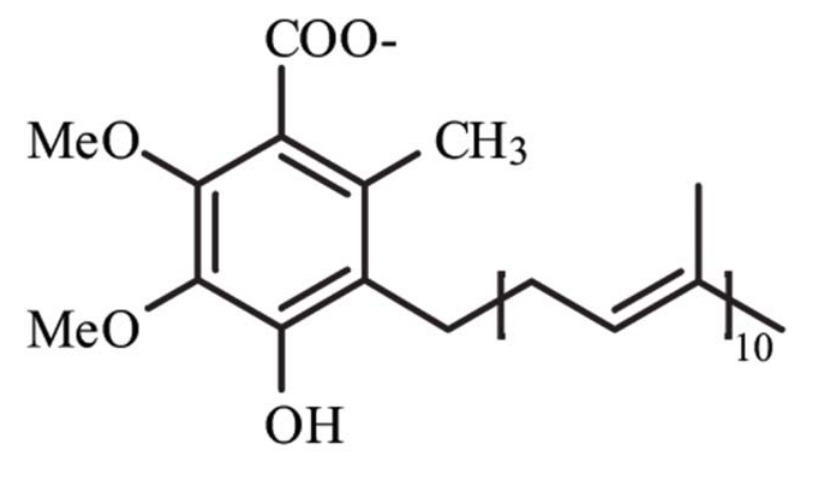
Figure 1. Structure of Coenzyme Q10. Me, methyl